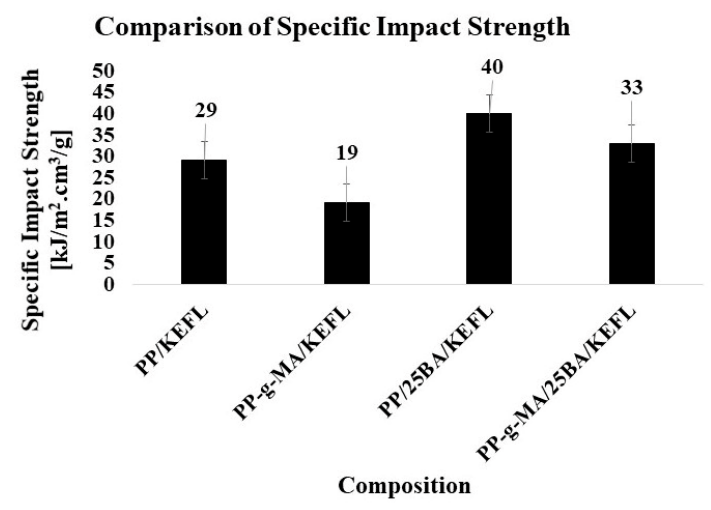
Figure 13. Comparsion of impact strength of PP composites with modified PP composites.